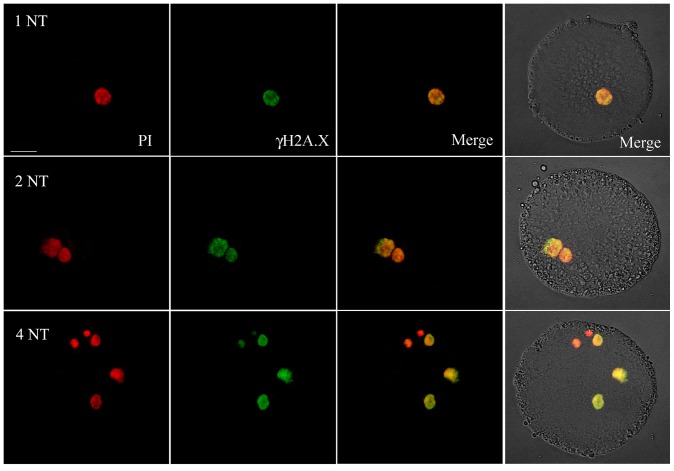
γH2AX immunostaining in pronuclei of oocytes injected with up to four nuclei from freeze-dried lymphocytes.NT = nuclear transfer, 4NT = 4 pronuclei (one fragmentated), PI  = pronuclei stained with propidium iodide; γH2AX = phosphorylated H2AX, a marker of DSBs and, indirectly, of DNA repair; Merge = PI+γH2AX. Scale bar = 20 µm.